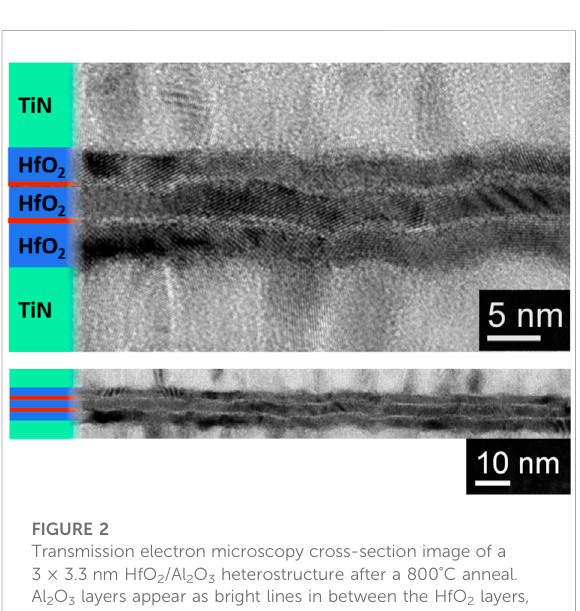
FIGURE 2 Transmission electron microscopy cross-section image of a 3 × 3.3 nm HfO 2 /Al 2 O 3 heterostructure after a 800 ° C anneal. Al 2 O 3 layers appear as bright lines in between the HfO 2 layers, indicating no signi fi cant